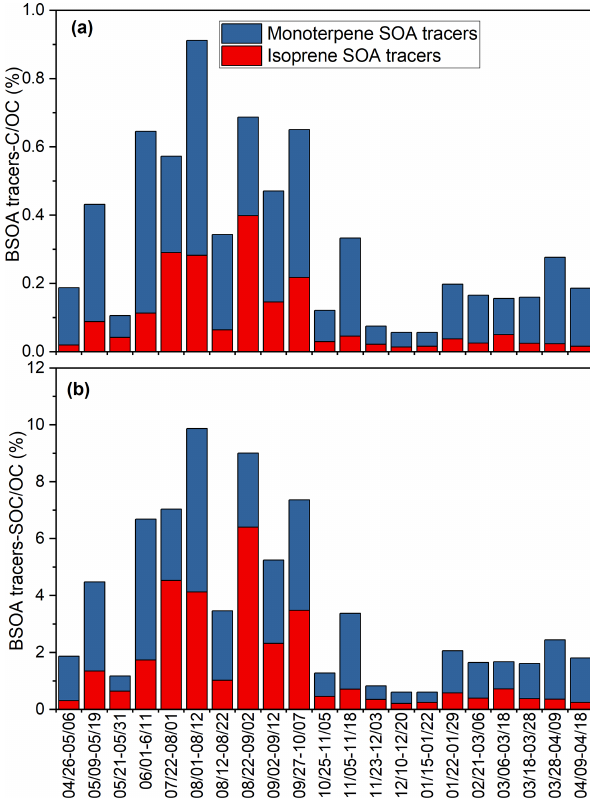
Figure 8. Contribution of (a) isoprene and monoterpene SOA trac- ers of C in ambient OC (percent) and (b) isoprene and monoter- pene SOA tracers SOC in ambient OC (percent) in Gosan aerosol samples during April 2013–April